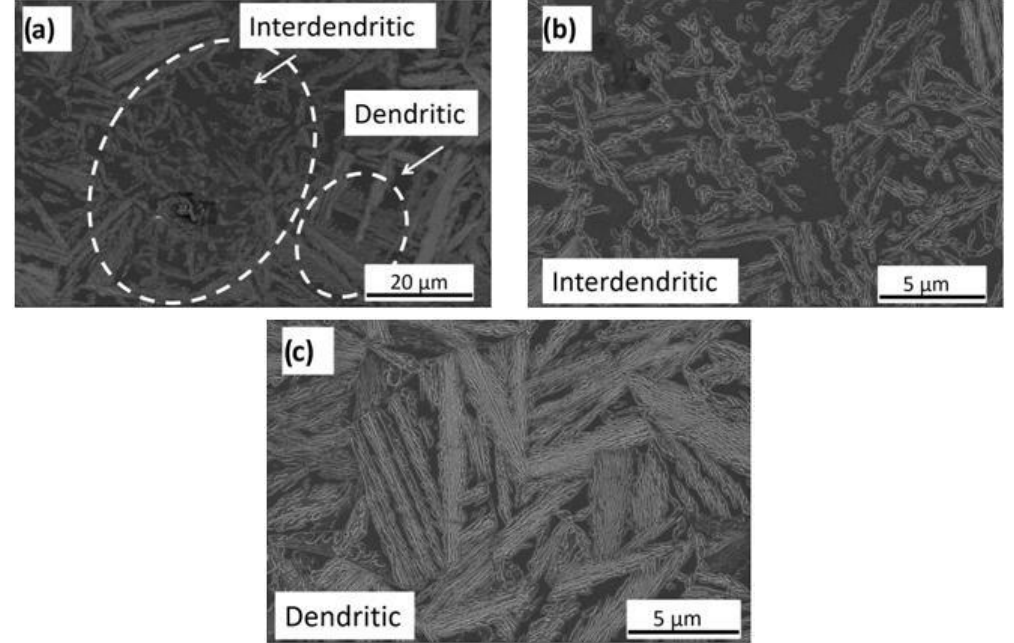
Figure 10. SEM micrographs showing: ( a ) the microstructure obtained at 330 °C for 360 min, ( b ) interdendritic and ( c ) dendritic regions. Nital 2%.